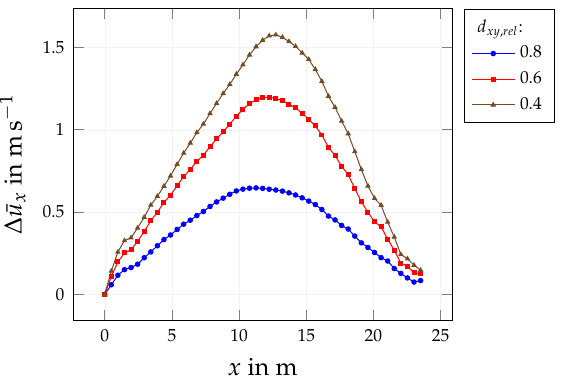
Figure 28. Difference between velocity profiles ¯ u x ( x ) of increasing and decreasing coverage for different relative fragment sizes d xy , rel in inlet channel domain.